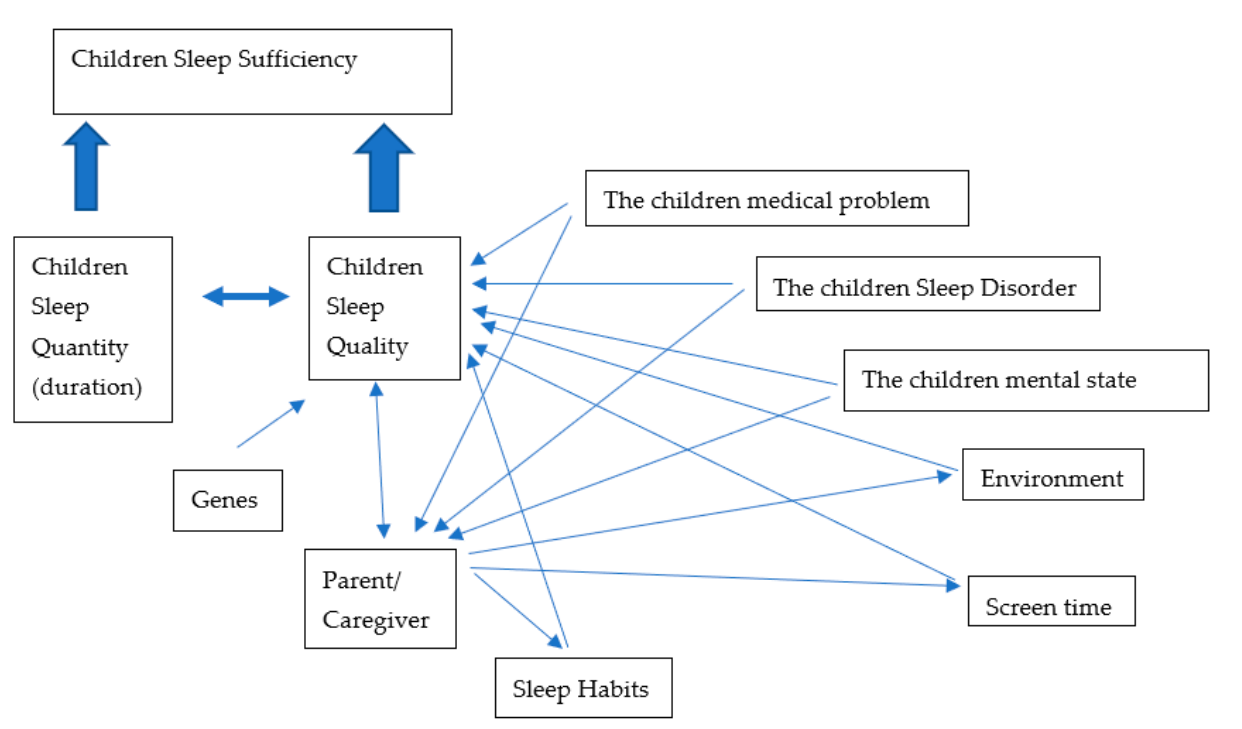
Figure 1. Factors that affect sleep quality and the interactions between factors.